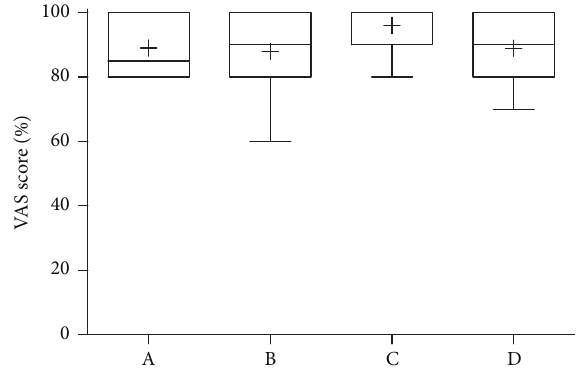
Figure 2: Evaluation of the online tutorials by lung ultrasound experts ( 𝑛 = 9 , members of Volpicelli et al. [8]). Experts revised as peer group the e-learning by grading the content within a data sheet